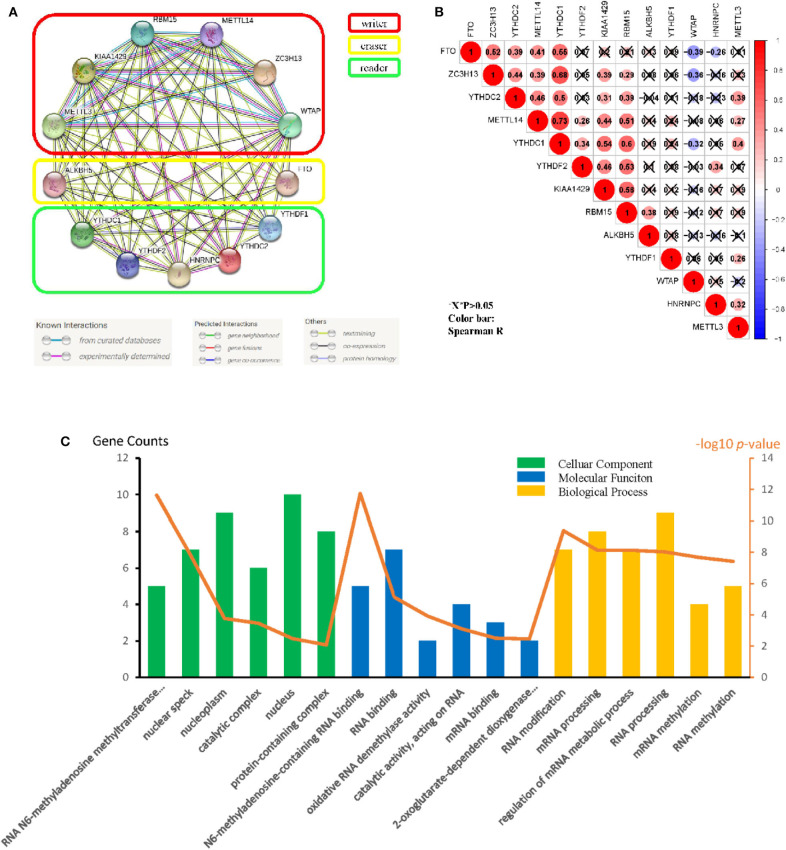
Protein–protein interaction (PPI), go ontology, and correlation of the m6A RNA methylation regulators. (A) M6A modification-related Protein–protein interactions among the 13 m6A RNA methylation regulators. (B) Spearman correlation analysis of the 13 m6A methylation modification regulators. (C) Gene ontology (GO) analysis classified regulators into BP (Biological Process), CC (cellular Component), and MF (Molecular Function) groups.